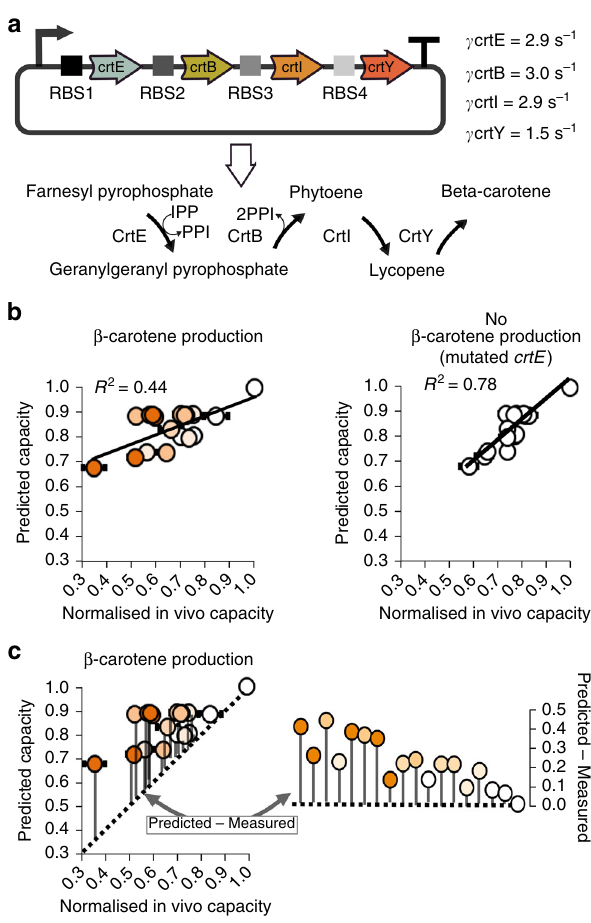
Fig. 4 Predicting the burden of operon designs for the beta-carotene biosynthesis pathway. a Diagram of the beta-carotene pathway and the γ - values for the four enzyme-encoding sequences as measured by the cell lysate capacity assay (see Supplementary Fig. 7). The operon is designed with partially randomised RBS sequences and one of three promoters: BBa_J23113 (weak), BBa_J23106 (medium), or BBa_J23100 (strong). b Model-predicted burden of each operon design compared to the measured in vivo capacity of E. coli expressing the operons with or without an inactivating mutation in the crtE gene (prediction method described in Supplementary Fig. 8). The orange intensity in each circle represents the measured beta-carotene level for each strain (see Supplementary Fig. 9). Error bars show standard error of three independent repeats. c Model- predicted burden of each operon design compared to the measured in vivo capacity of E. coli expressing the active pathway (same data as b , non- mutated pathway on left). The diagonal dot line represents equality between predicted and measured normalised in vivo capacity. Grey bars indicate the difference between the predicted and measured normalised in vivo capacity of the 17 operons. Right plot compares the relative differences between predicted and measured normalised capacity for the 17 operons and the strain-only control. Operons are ranked from low to high-in vivo capacity values. Values are normalised to the capacity obtained with capacity monitor plasmid